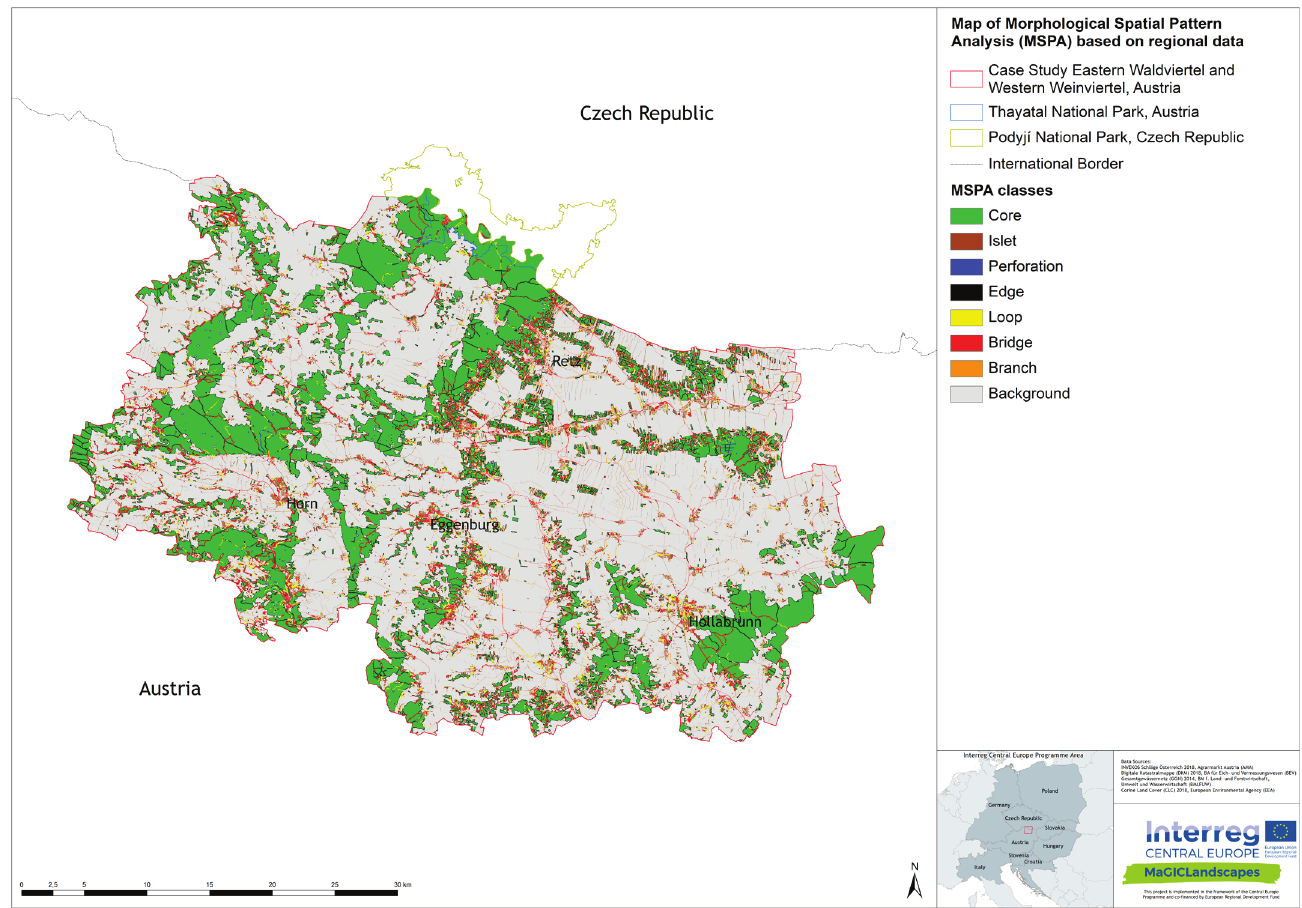
Figure 6. Map of Morphological Spatial Pattern Analysis (MSPA) of GI in the Austrian case study based on regionalised